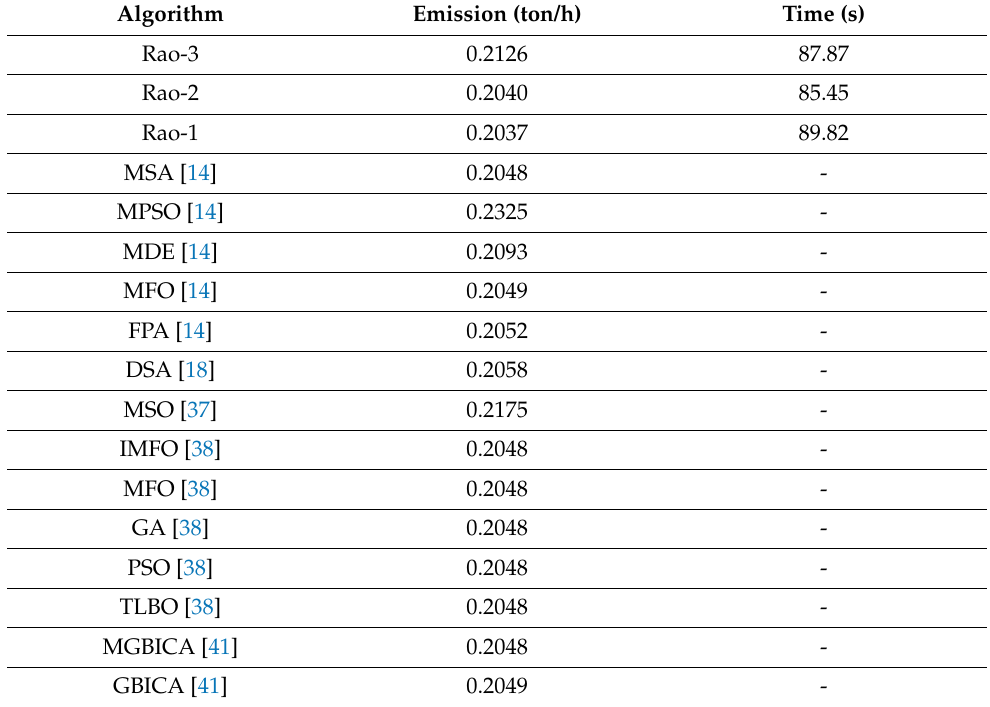
Table 9. Case 6: ECM in the IEEE 30-bus